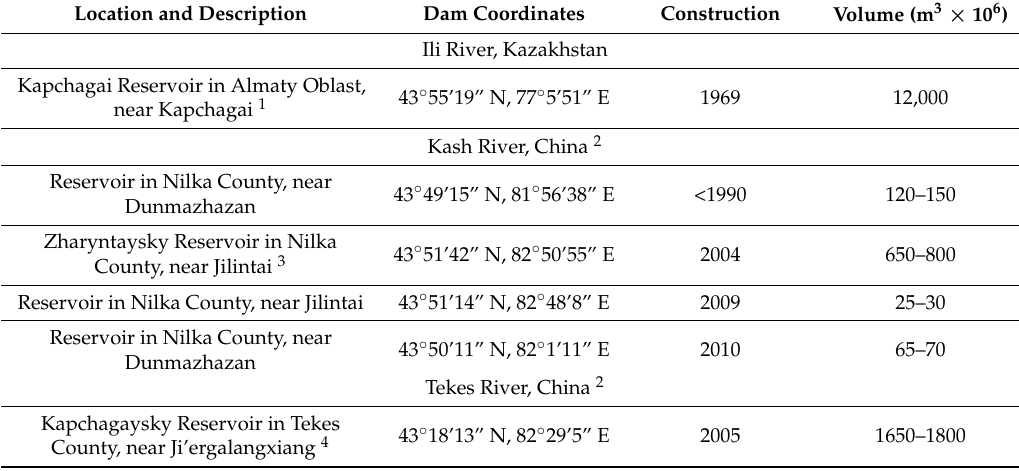
Table 2. Reservoirs on the Ili River and its major